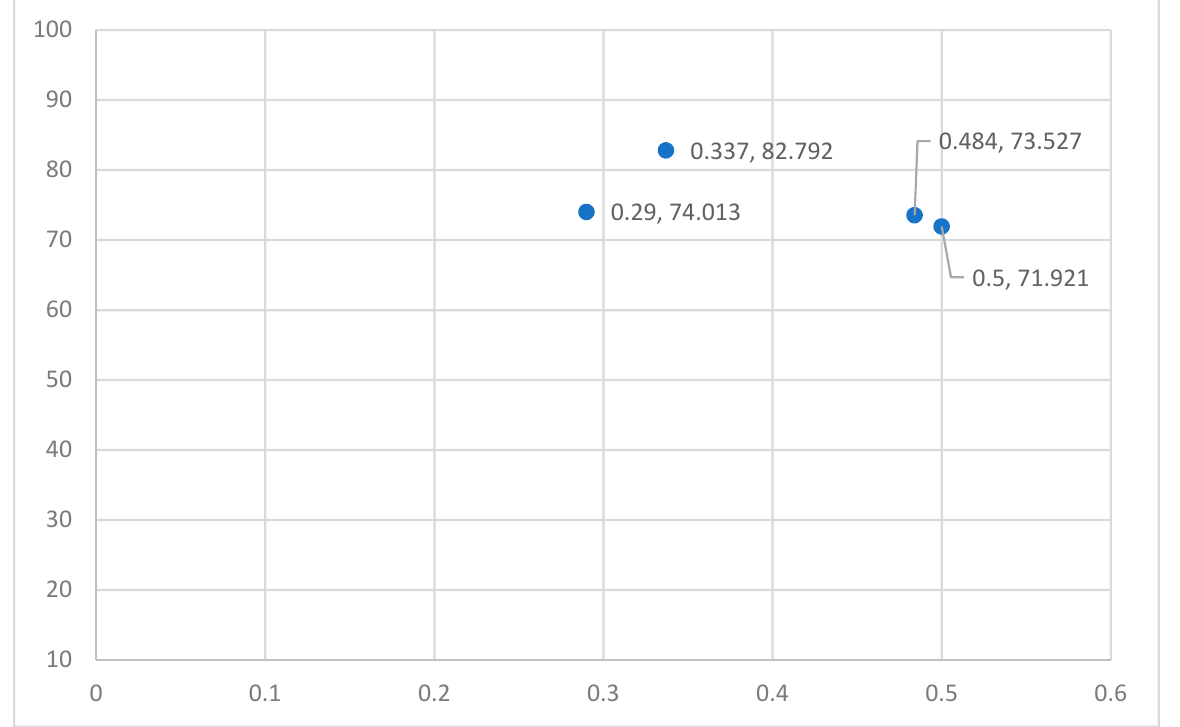
Figure 4. IPMA for innovativeness.